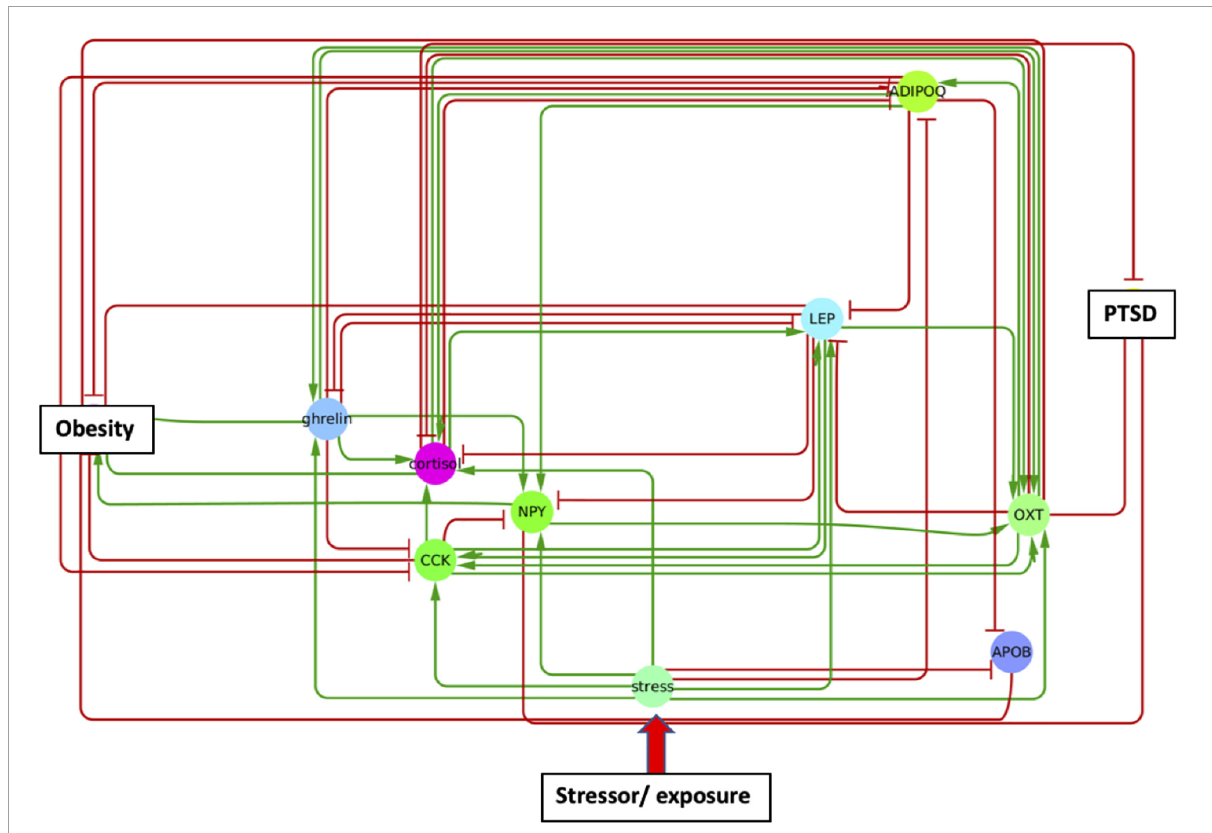
FIGURE3 A single metabolic mediator subnetwork. Subnetwork of shortest paths linking stress to PTSD and obesity through only one intermediate metabolic mediator. Shared paths leading to both PTSD and obesity involved the convergent actions of cortisol, oxytocin (OXT), and neuropeptide Y